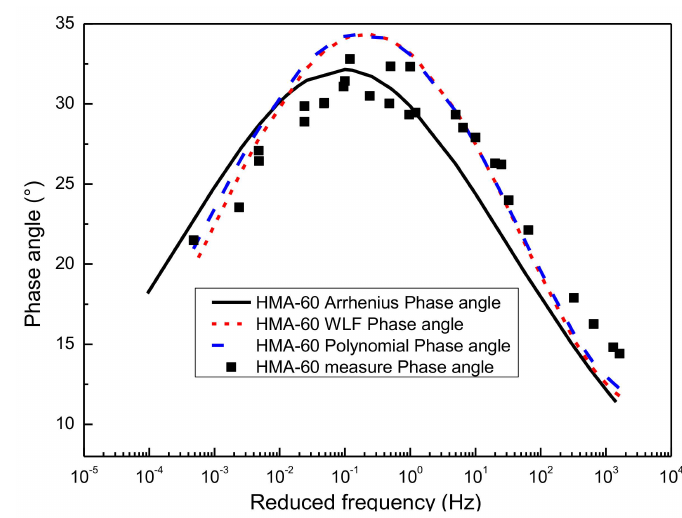
Figure 11. Predict phase angle master curve of HMA-60 from SM.